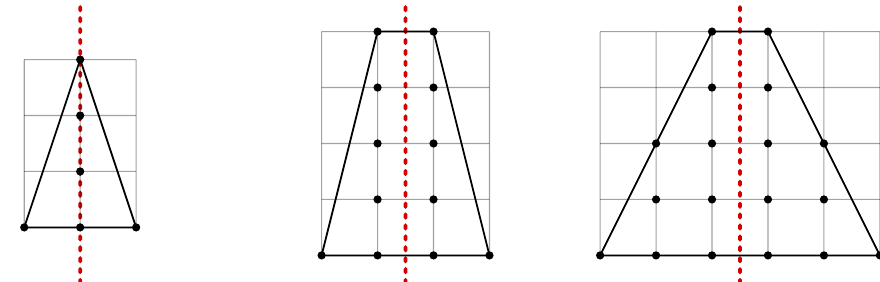
Figure 22. Examples of trapezoids, which admit anomaly-free horizontal fixed line orientifolds. Horizontal/vertical line orientifold. Toric diagrams symmetric with re- spect to a horizontal/vertical axis always lead to anomaly-free orientifold the- ories when the two O-lines have opposite signs . When the signs are the same, instead, in order to yield a non-anomalous orientifold theory the toric diagram of the singularity must be a trapezoid